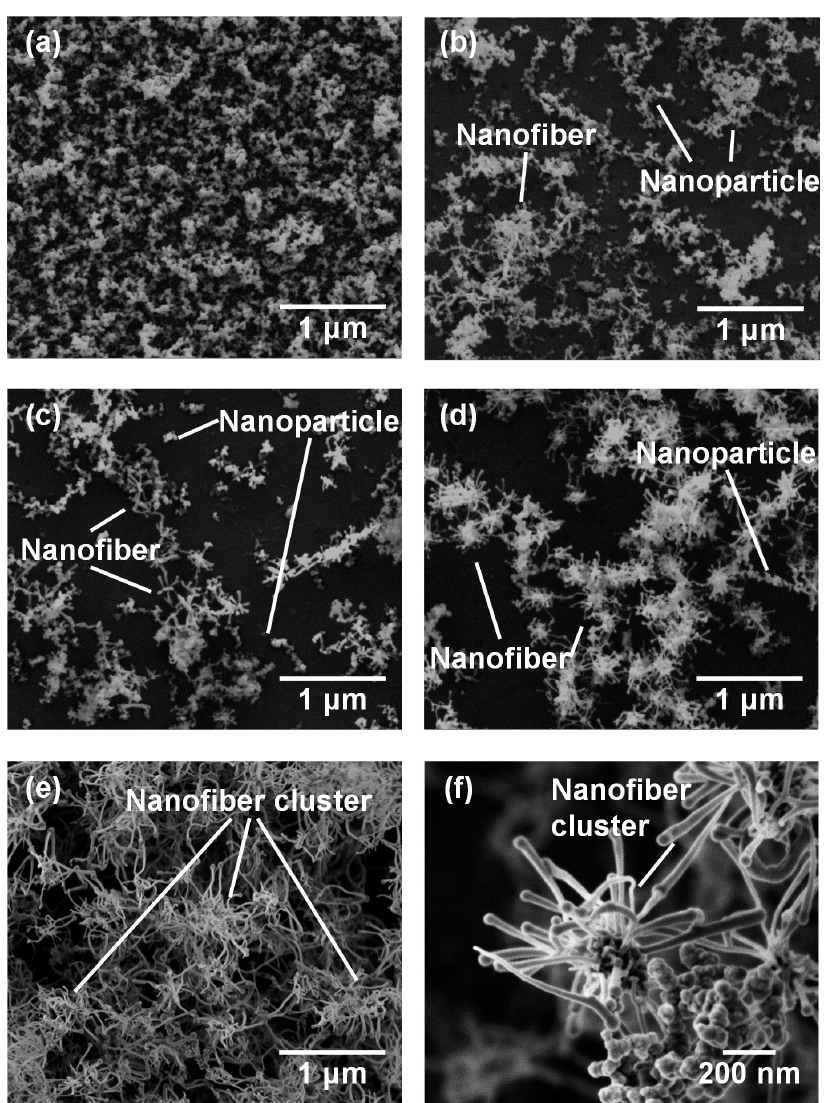
Figure 3. SEM photographs of nanomaterials generated at various gas pressures: ( a ) 1.3, ( b ) 13, ( c ) 40, ( d ) 67, and ( e , f ) 101 kPa.